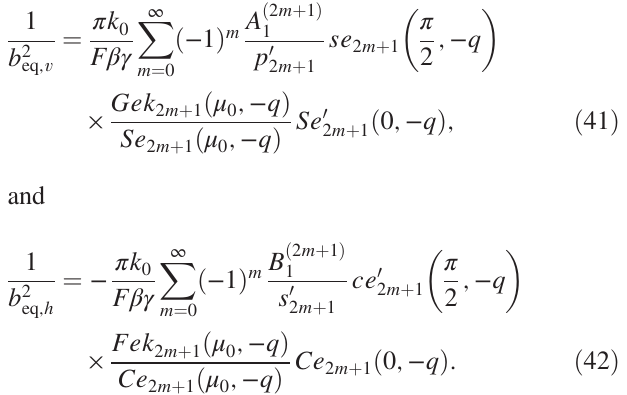
FIG. 3. Dependence of space charge vertical impedance with wave number for b e ¼ 3 . 5 cm and β ¼ 0 . 5 . Comparison of Eq. (33) (black, blue and red curves) with the circular pipe case given by Eq. (35) (dashed orange curve), with IW 2 D code results for parallel plates (dashed yellow curve), and with the asymptotic expressions (36) and (38) valid for low frequency (brown, magenta and green lines).